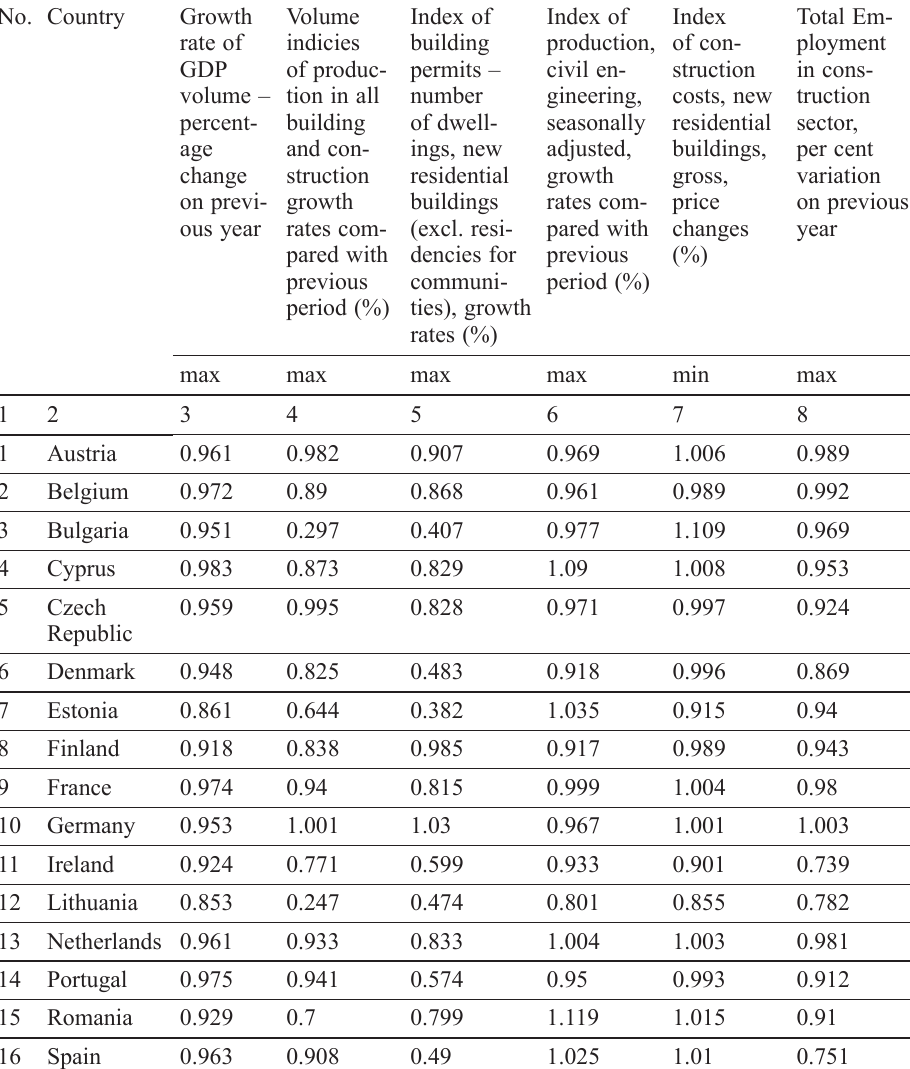
Table 2. The initial matrix without negative values